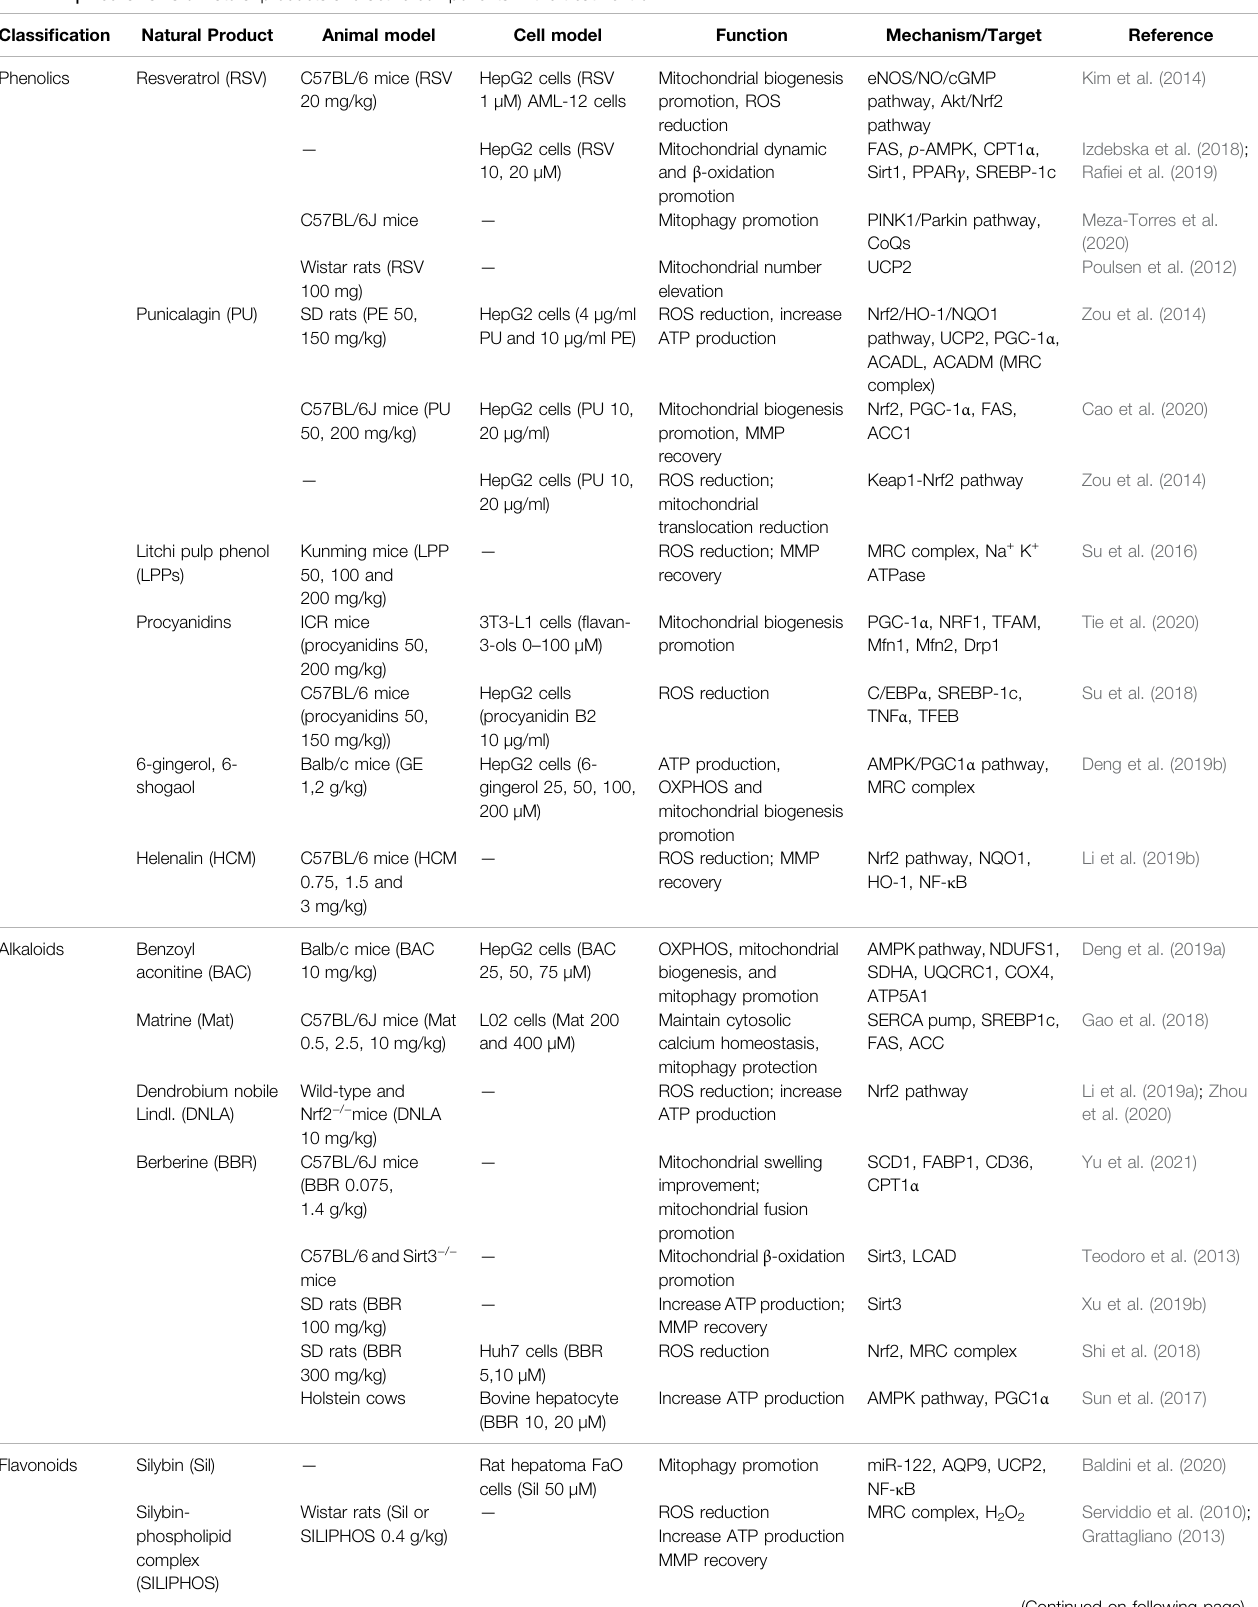
TABLE 1 | Mechanisms of natural products and active components in the treatment of